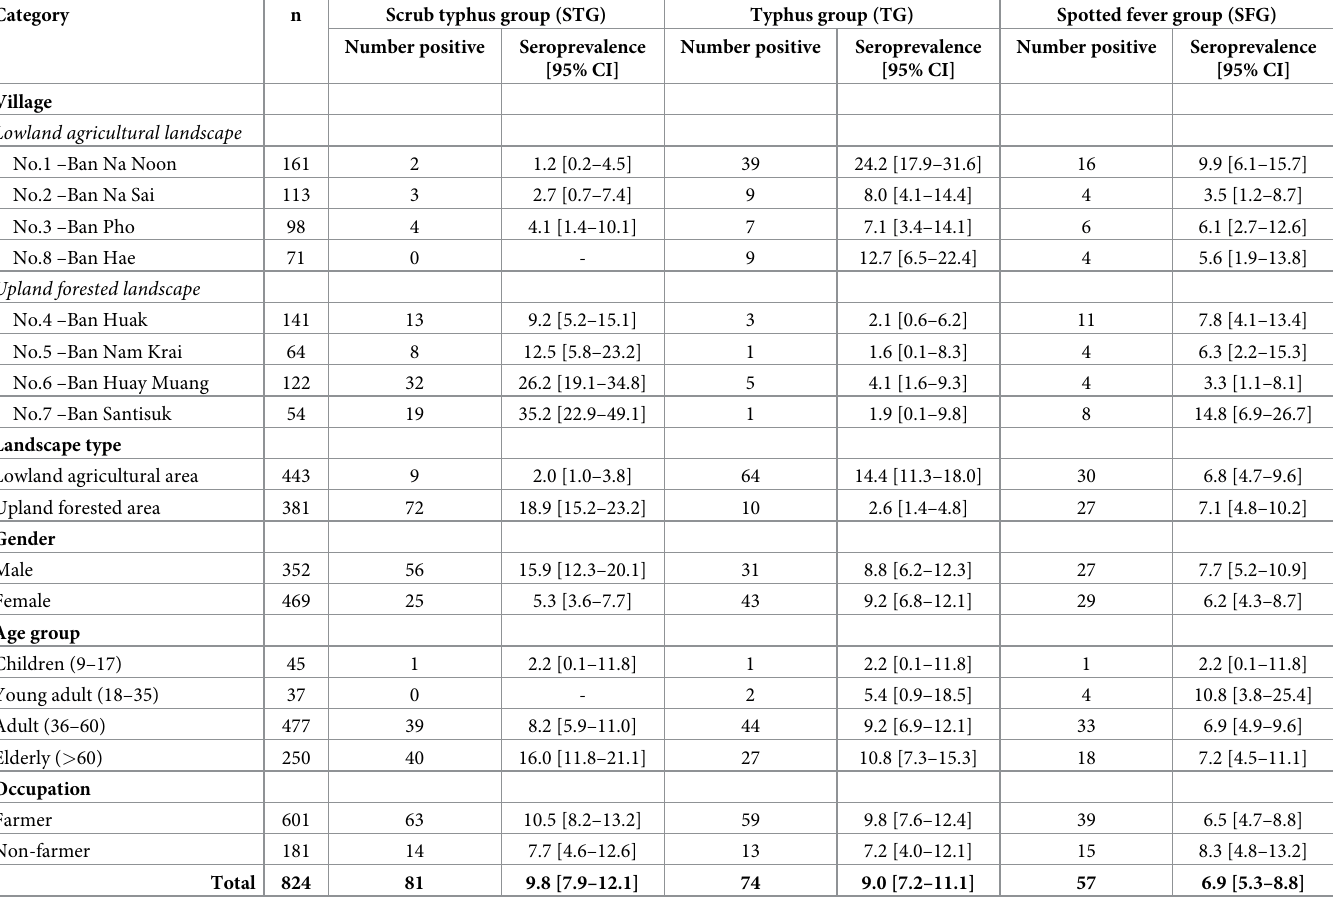
Table 1. Seroprevalence of human exposure to rickettsial infections, scrub typhus group (STG), typhus group (TG) and spotted fever group (SFG) in rural commu- nities of Nan Province, Thailand.